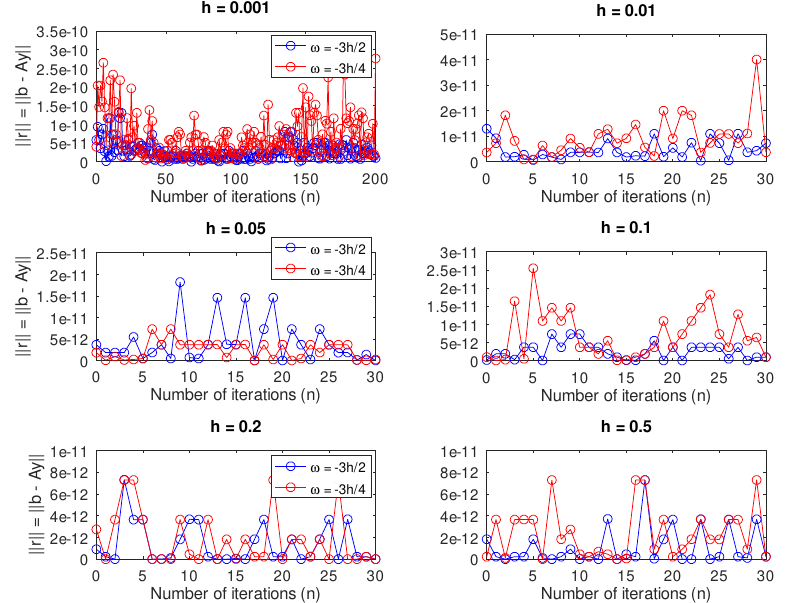
Figure 8. Comparison of the norm of the residual for different values of h using the discrete schemes Figure 8. Comparing the norm of the residual for different values of h using the discrete schemes (3)–(6) corresponding to ω = (3)–(6) corresponding to ω =